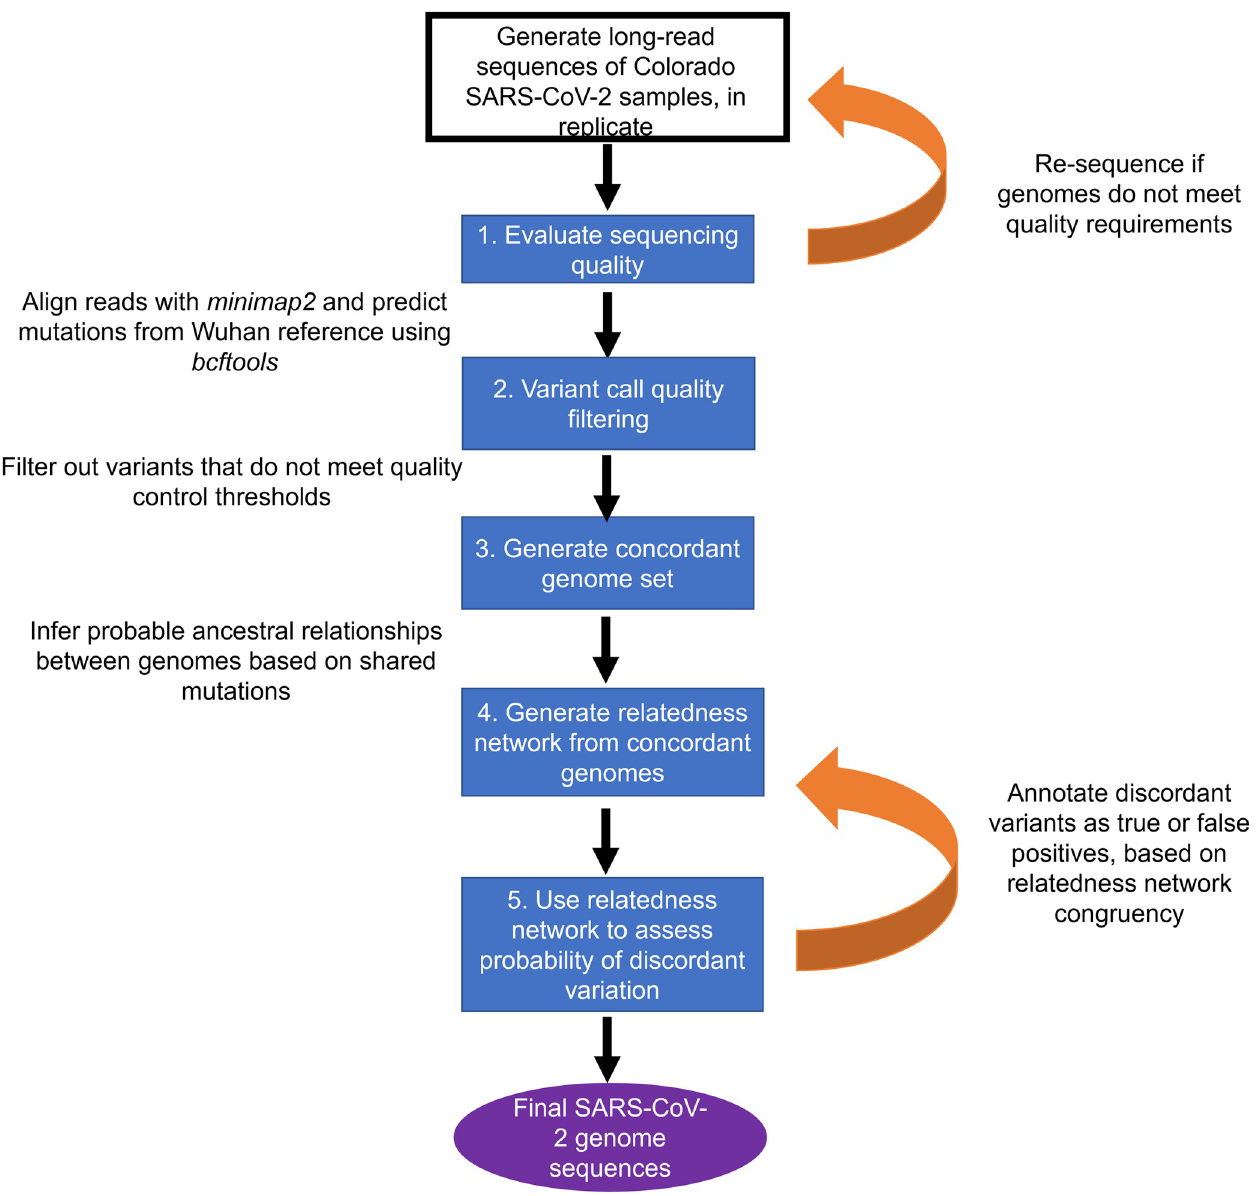
Fig 1. Flow chart of SARS-CoV-2 sequencing, variant prediction, variant quality analysis and relatedness network generation. Blue boxes describe the purpose of each stage of analysis, free text designates the specific method used at each stage and orange arrows indicate points where steps were repeated iteratively until sufficient quality metrics were